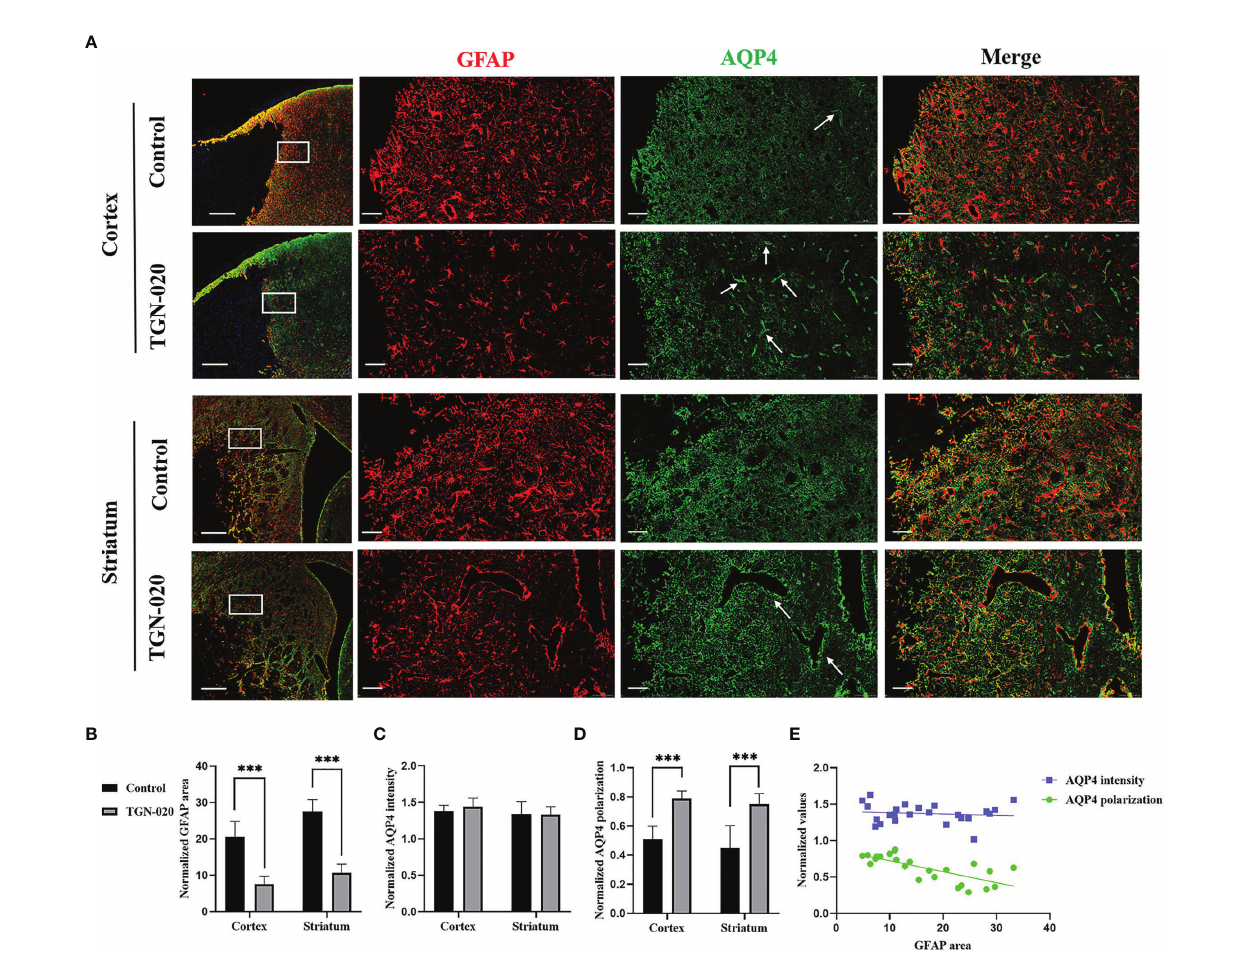
FIGURE 3 | Peri-infarct astrogliosis and AQP4 expression patterns in the two groups of rats. (A) Immunostaining of GFAP (red) and AQP4 (green) in the peri-infarct cortex and striatum in TGN-020- treated rats and control rats. White boxes in the fi rst column indicate the ROIs used for GFAP and AQP4 analysis. The arrows show AQP4 located in the perivascular region. Scale bars = 500 and 50 µm. (B – D) Comparisons of GFAP-positive area and AQP4 expression patterns in the peri-infarct cortex and striatum between the two groups. (E) Correlations between peri-infarct AQP4 expression patterns and the extent of astrogliosis. *** P <